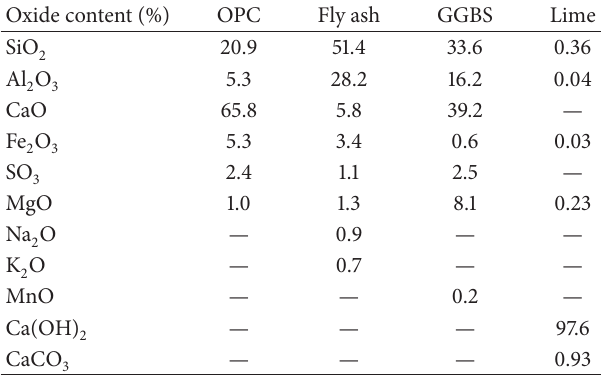
Table 2: Chemical properties of the materials from suppliers’